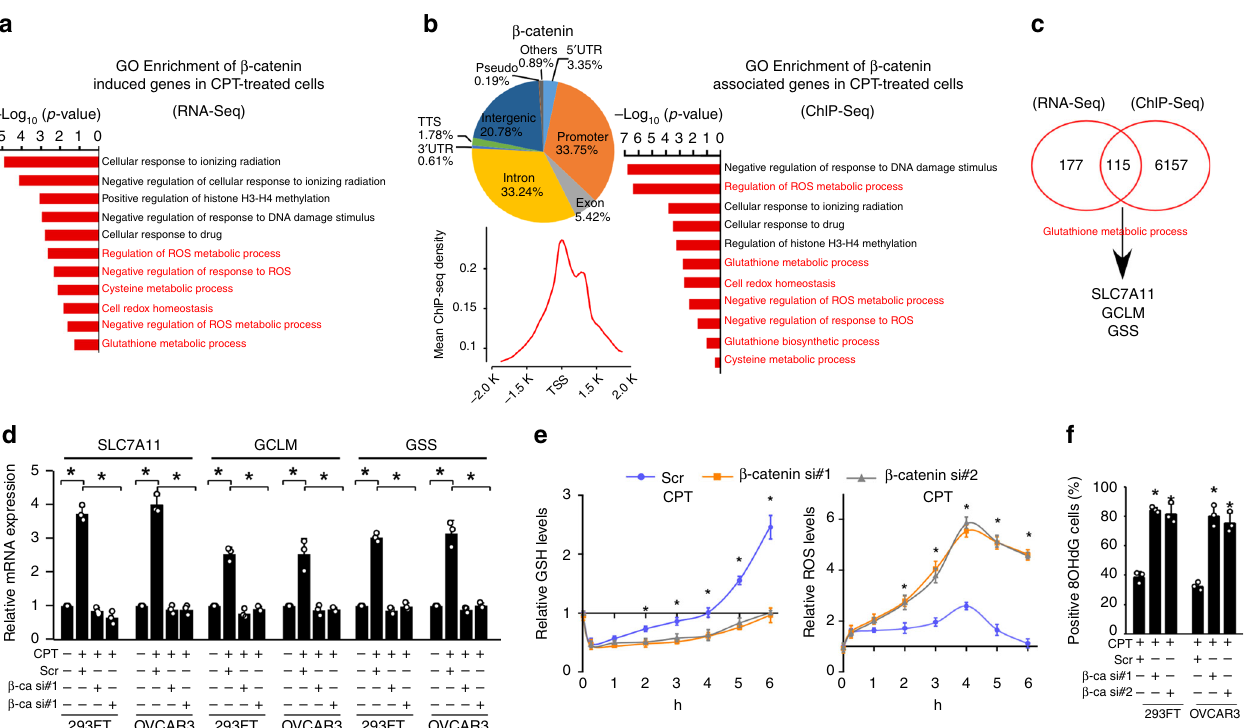
Fig. 2 β -catenin contributes to genotoxic stress-activated glutathione metabolic processes. a , b GO enrichment analysis of β -catenin-regulated transcripts identi fi ed using RNA-seq ( a , PRJNA543096) or ChIP-seq ( b , PRJNA543097) pro fi ling in CPT (10 μ M, 1 h)-treated 293FT cells. The x -axis shows the enrichment scores as calculated by the – log10 ( p- value). b (left): occupation and average ChIP-seq peak calling around the β -catenin peaks ’ center. c Analysis of RNA-seq (PRJNA543096) and ChIP-seq (PRJNA543097) pro fi les indicated that β -catenin targeted the promoters and